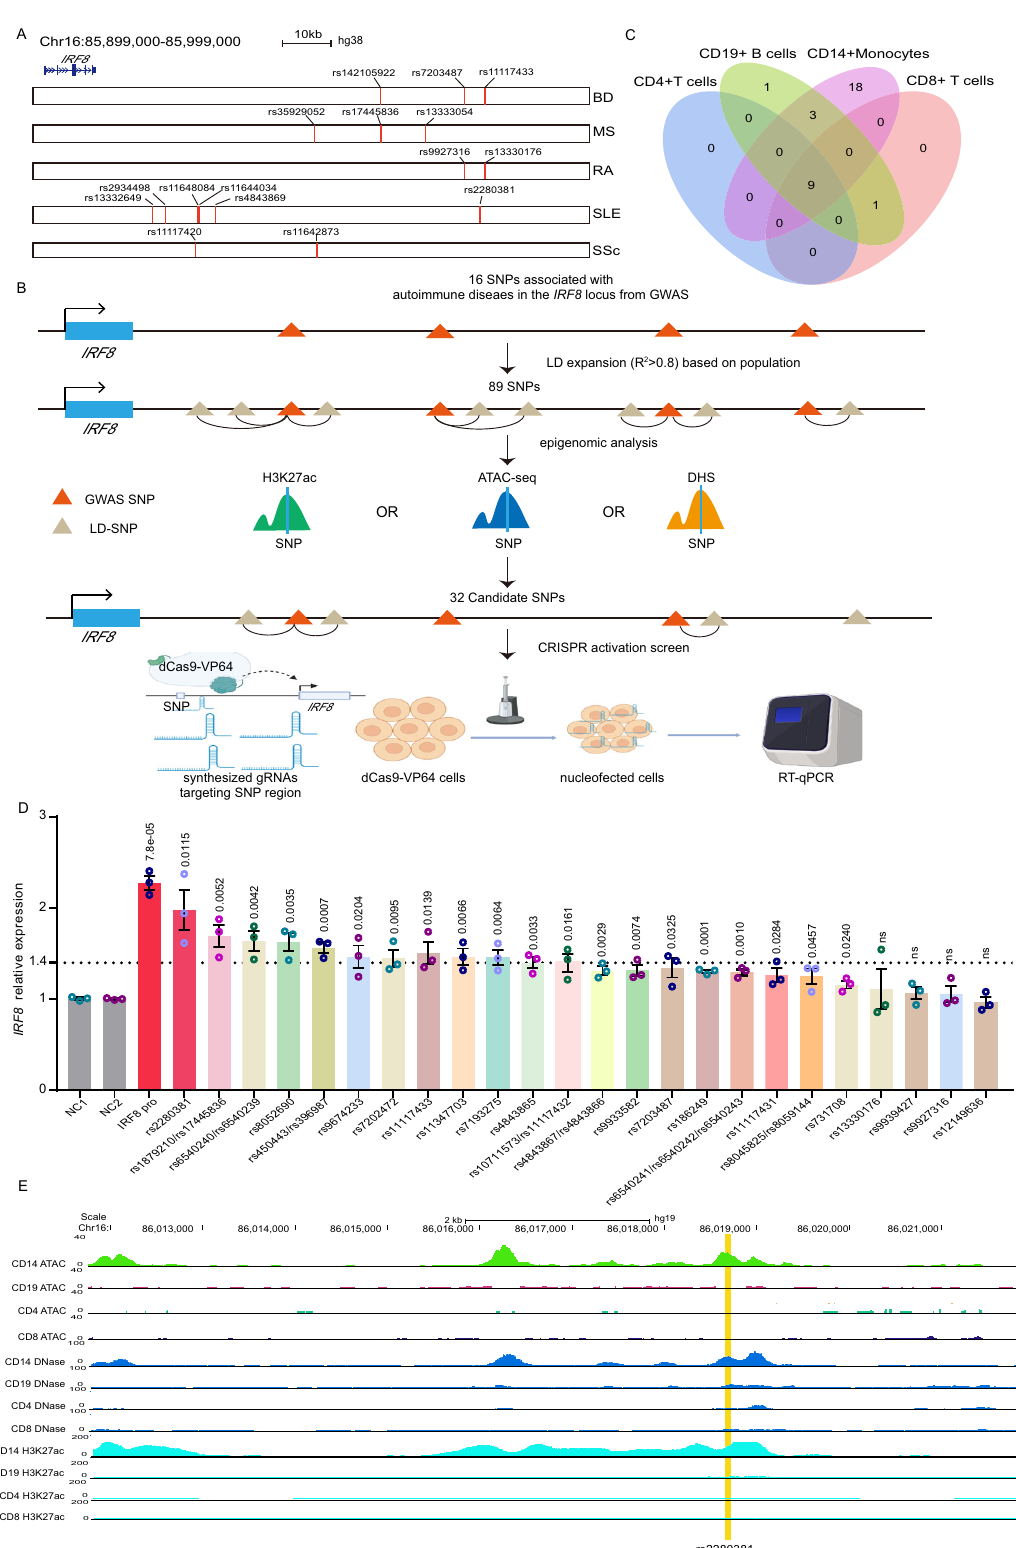
Distal enhancers typically form enhancer-promoter loops that affect the expression of target genes. To test whether such a linkage exists between the IRF8 promoter and the rs2280381 enhancer, we performed circularized chromosome conformation capture sequencing (4C-seq) to detect looping interactions of